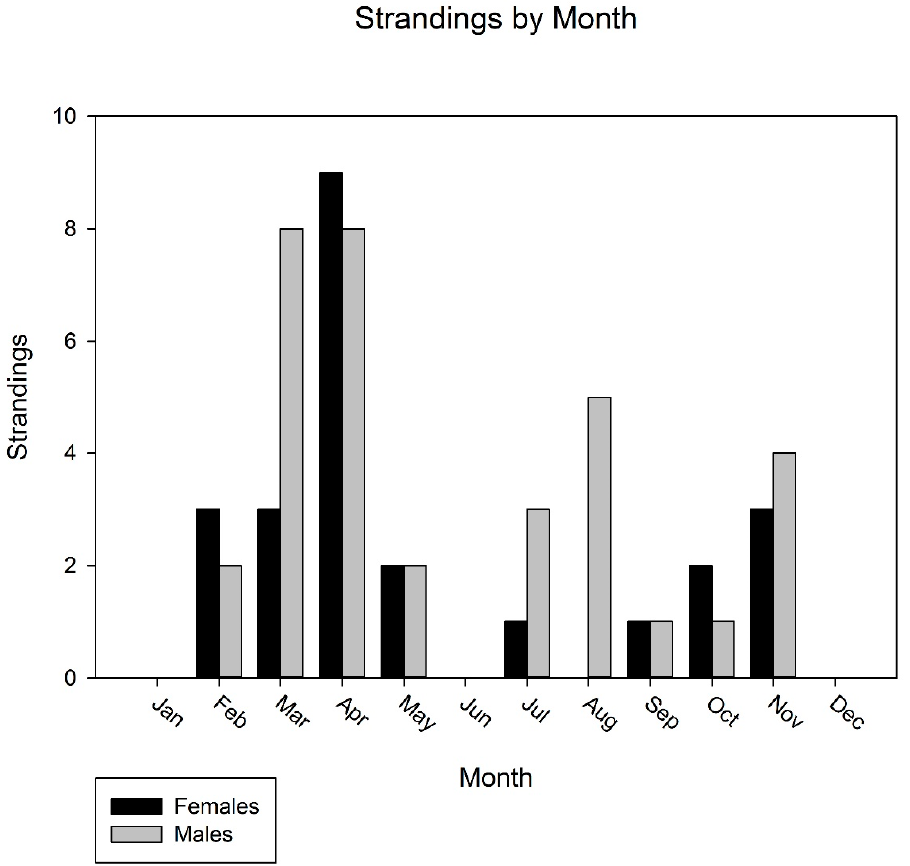
Figure 4. Kemp’s ridley sea turtle, Lepidochelys kempii , strandings included in the present study by month collected. Data is summarized for all years, 1994–1999. Increasing gonadal activity associated with seasonal reproductive activity occurs between November and April. Kemp’s ridleys nest in Mexico and Texas, USA, from March through August.